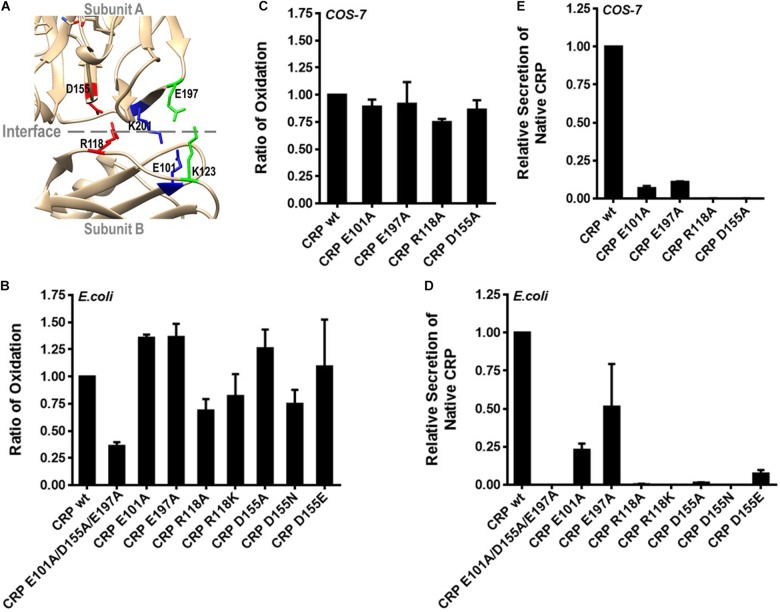
R118-D155 salt bridging mediates pentameric assembly of CRP. (A) The three inter-subunit salt bridges R118-D155, E101-K201 and K123-E197 of CRP are colored as red, blue and green, respectively. (B) CRP wildtype (wt) or mutants with a signal peptide of ALP or its own were expressed in E. coli or COS-7 cells. (B,C) The correct bonding of the intra-subunit disulfide bond in secreted CRP was determined by immunoblotting with 3H12 mAb (7). The intra-subunit disulfide bond formed normally in CRP mutants with one of the salt bridges disrupted. (D,E) The secretion of pentameric CRP was determined by sandwich ELISA with 1D6 mAb (7). Only the disruption of R118-D155 salt bridge completely abrogated the secretion of pentameric CRP.